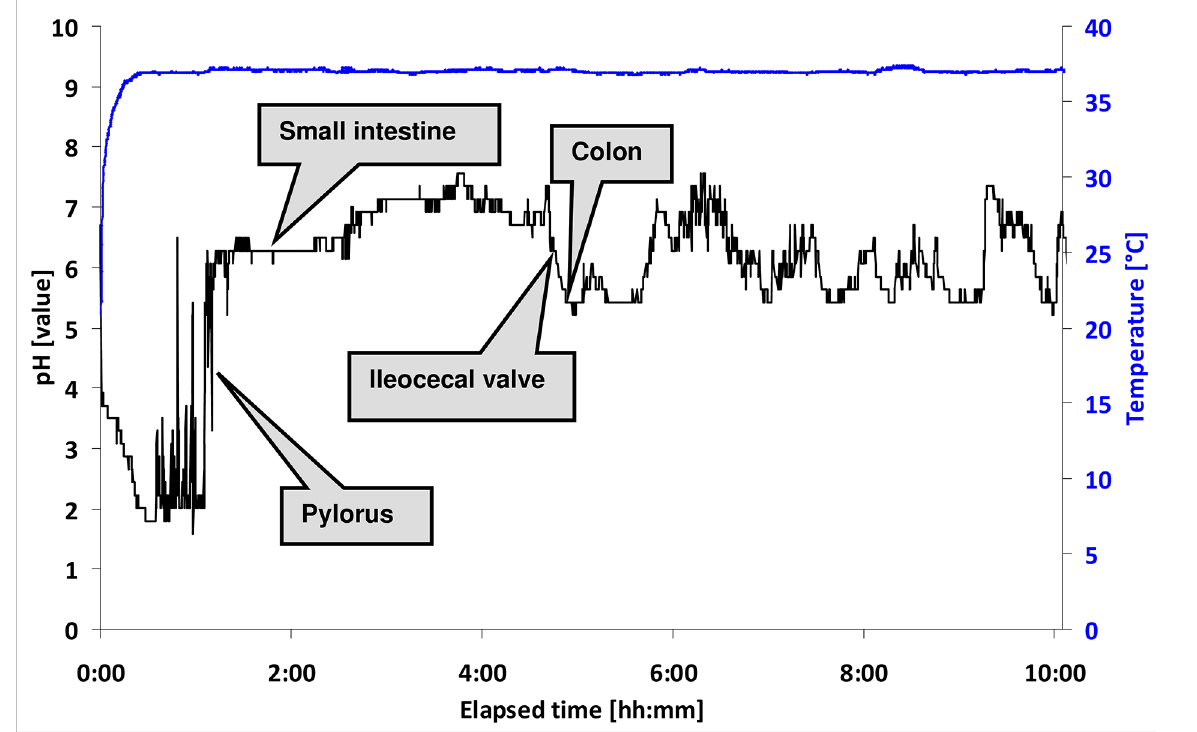
Fig 3. Example of pH-profile of the first 10 hours after intake of the IntelliCap capsule (subject 14).